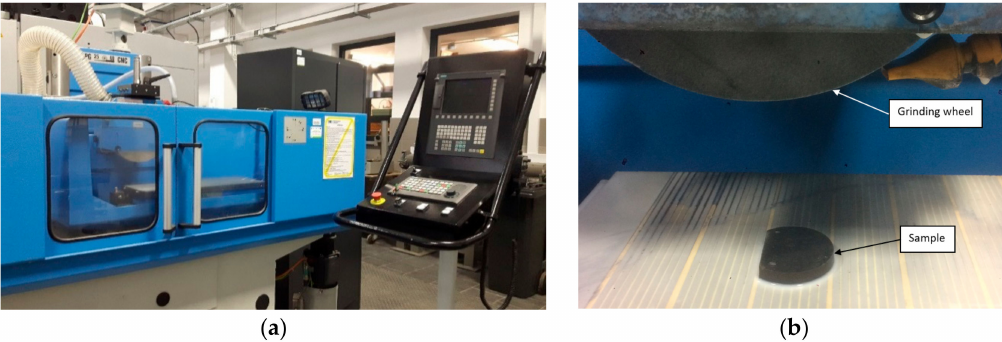
Figure 3. Horizontal-spindle (peripheral) surface grinder SPG 25 × 60: ( a ) General view, ( b ) working space with the sample